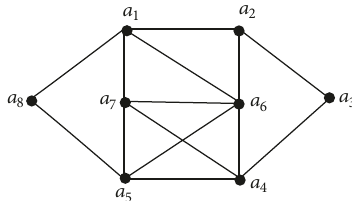
Figure 12: Simple graph (𝑋 1 , E 1 ) .